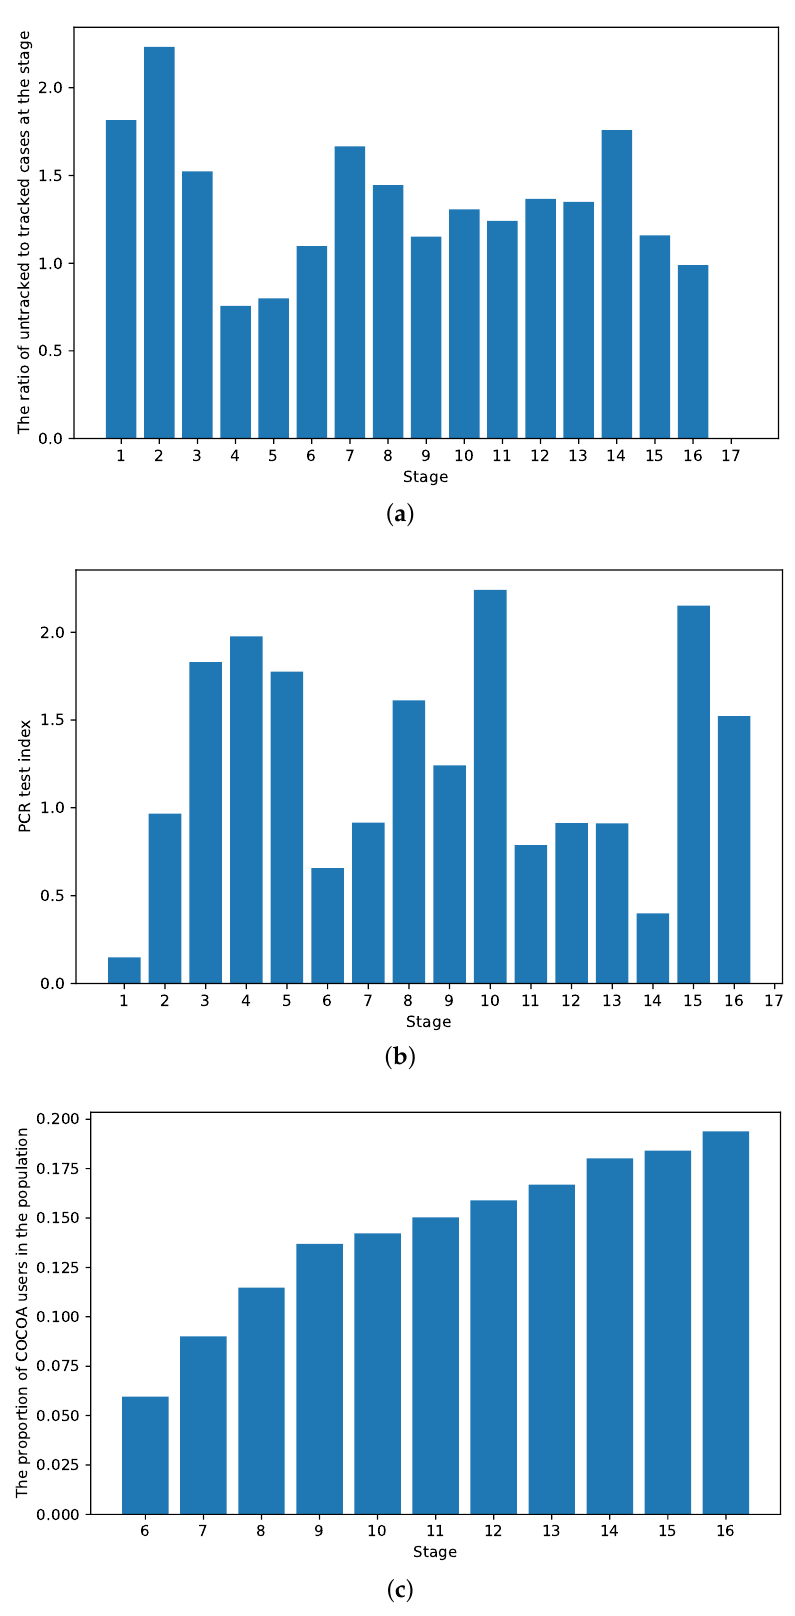
Figure 5. The variables for the fitting of the model parameters and characterization of the strategies. ( a ) The ratios of untracked to tracked cases in the stages. ( b ) PCR test indexes in the stages. ( c ) The proportions of COCOA app users in the